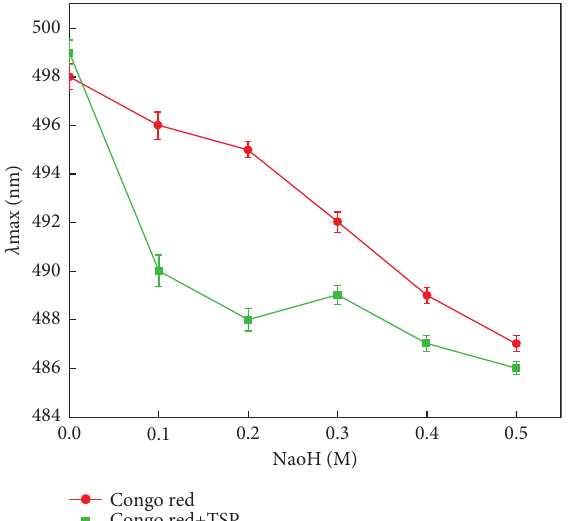
Figure 3: Plots of the maximum absorption of Congo Red and TSP Congo Red complex at various concentrations of NaOH. Statistical significance level of p < 0.05 calculated by Duncan’s test.